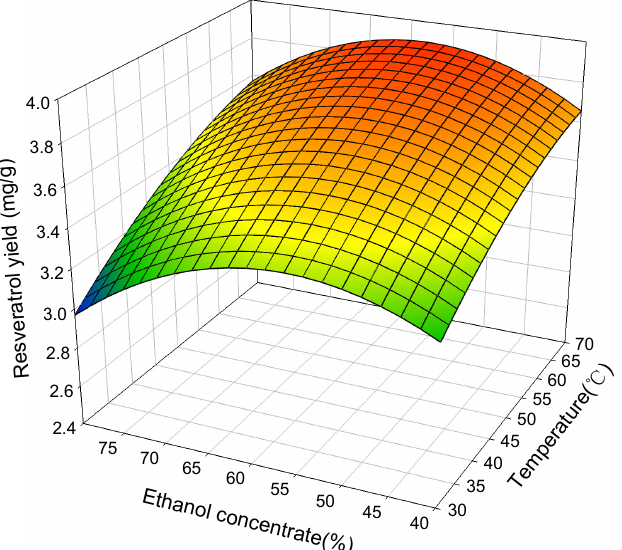
Figure 2. The effect of ethanol concentrate and temperature on the extraction yield of resveratrol at ultrasonic power of 120